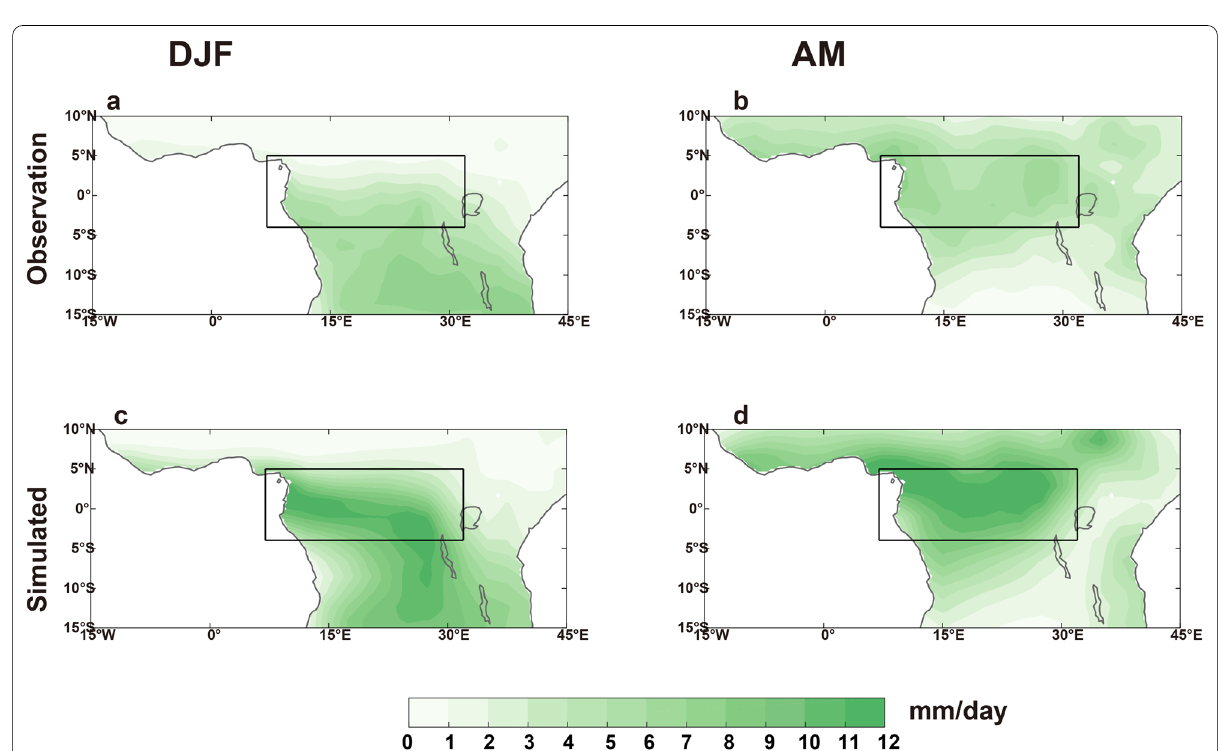
Fig. 5 Climatological precipitation pattern in observation and simulated. Upper panels ( a , b ) show observed (the mean of GPCP and CMAP) climatology in DJF and AM. Lower panels ( c , d ) same as a , b but for the